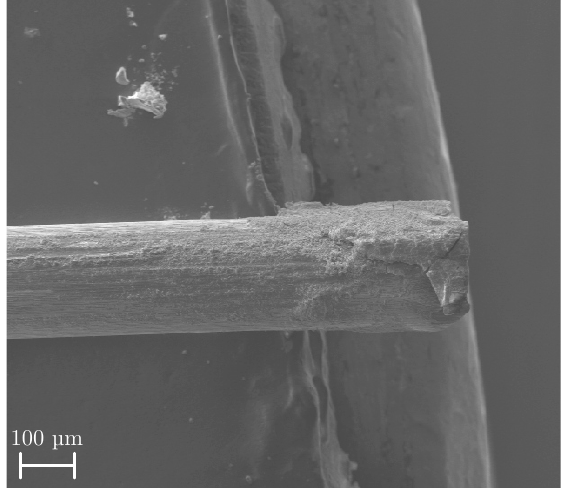
Figure 7. Adhering matrix particles (C7a) at the fibre end (steel fibre type 1).